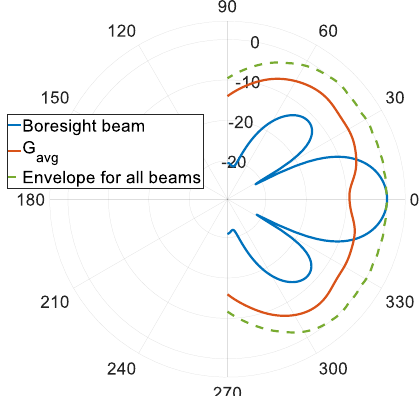
Figure 4. Example of G avg (dB, in red) in the azimuth plane ( θ = 90 ◦ ) for one BS within an arbitrary six-minute interval and normalized to the peak antenna gain. The green dashed line shows the envelope of the antenna gain for all the available beams. In blue is the gain for the beam pointing towards boresight.